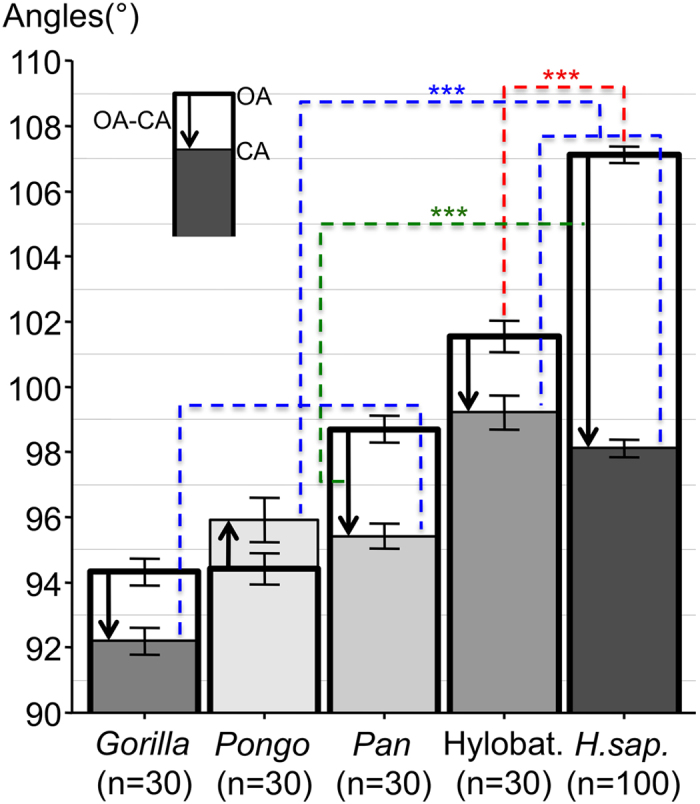
Histogram of orbital angle values (mean + /– SEM) of the different genera.Columns filled with different grey-levels and limited by a thin line denote the convergence angle (CA). White columns limited by a thick line denote the opening angle (OA). The difference between OA and CA is represented by an arrow. The arrow points up in all genera except Pongo in whom CA < OA. ***p < 0.001. Abbreviations used: Hylobat. = Hylobatidae; H. Sap. = Homo sapiens.